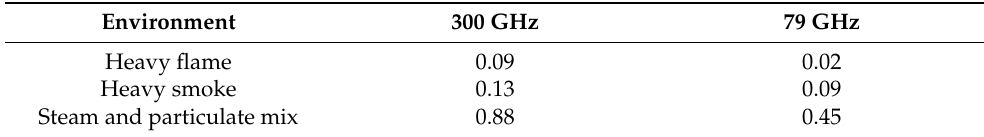
Table 2. Radar Signal Attenuation